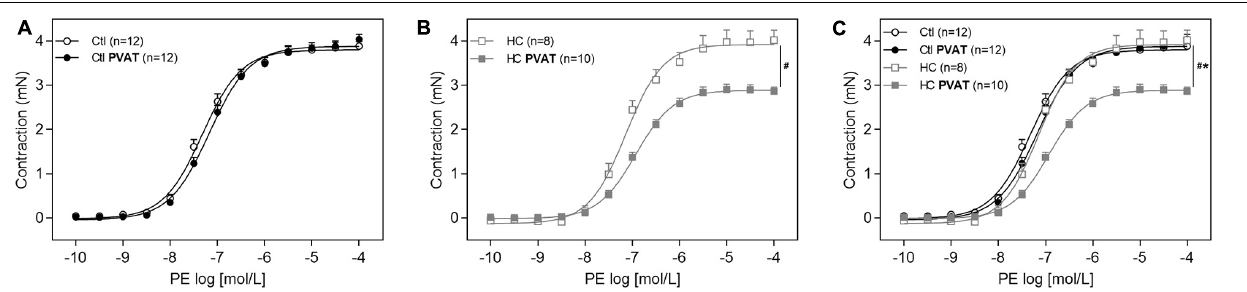
FIGURE 4 | Contractile response induced by PE in the presence or absence of PVAT in aortas of control and HC groups. Cumulative concentration-response curves for PE in the presence or absence of PVAT in aortas of (A) control, (B) HC, and (C) overlapping curves of control and HC groups. Values represent mean ± SEM. The total number of animals required to carry out the experiments in each group ( n ) is presented in parentheses in the graphs. Statistical significance was determined using two-way ANOVA followed by Holm–Sidak’s post hoc test. * p < 0.05 vs. control PVAT; # p < 0.05 vs. HC PVAT represent the differences in the Emax values.